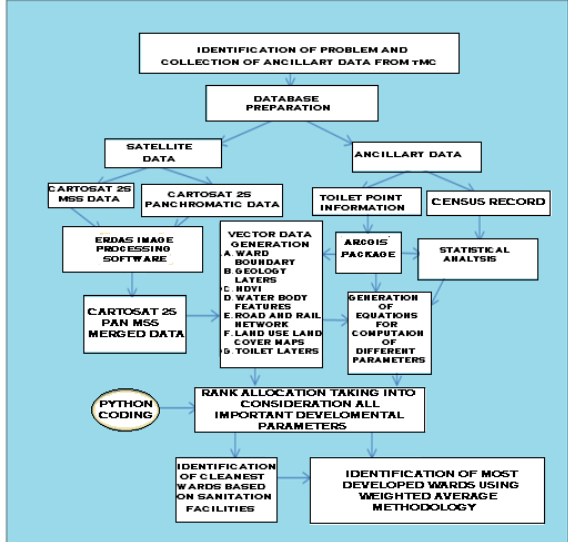
Road length and toilets were grouped under the INFRASTRUCTURE category. Percentage built-up and NDVI areas were grouped under SATELLITE DATABASE category.